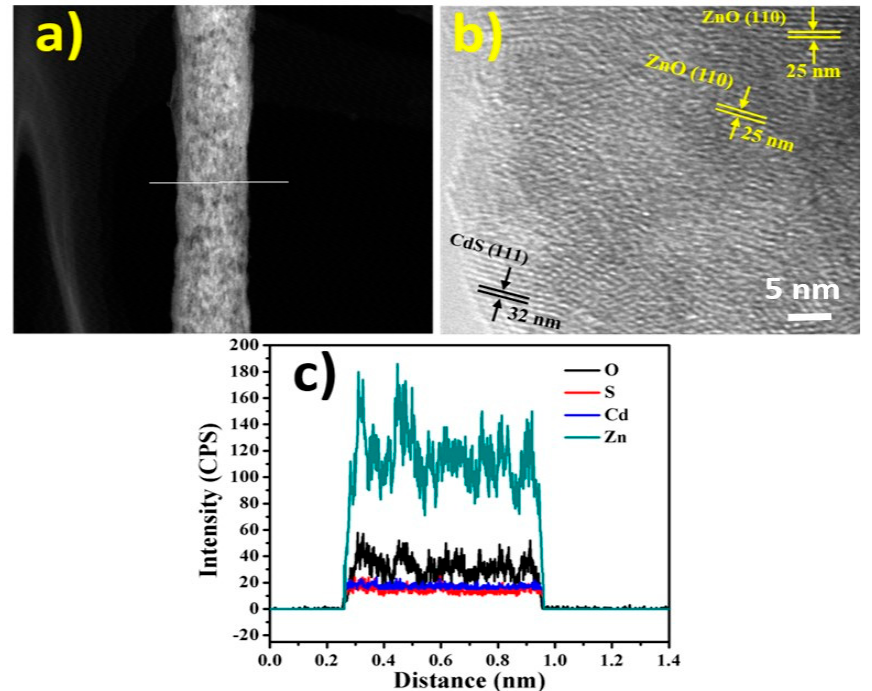
Figure 4. TEM analysis results for the calcined NFs. ( a ) Scanning TEM image for one NF along with the line-EDX analysis results. ( b ) High-resolution TEM image. ( c ) Line analysis for the TEM-EDX results for the line in panel ( a ).